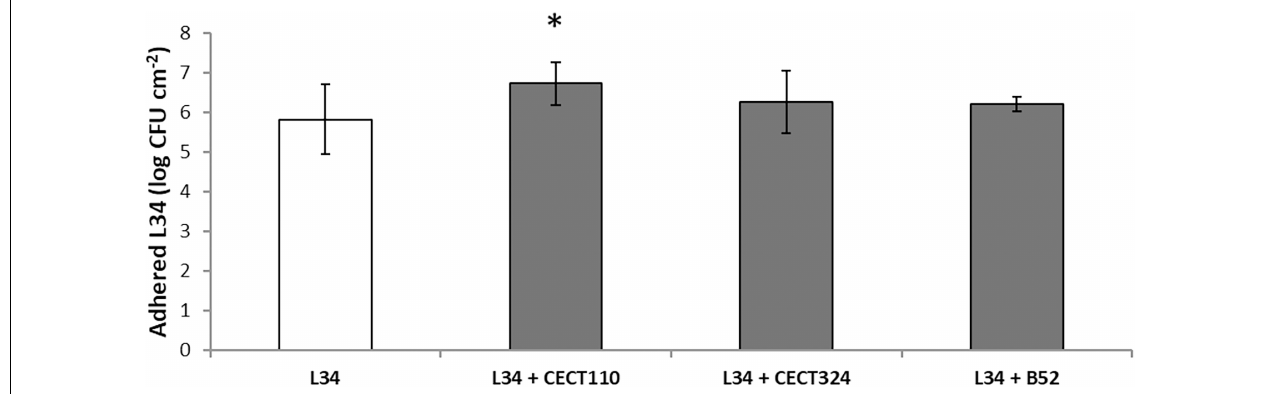
FIGURE 2 | Plate count values of adhered viable cells (AVC) corresponding to 48 h control biofilms grown on AISI 316 SS coupons. Bars represent mean values ( n = 15) expressed in CFU cm - 2 of L. monocytogenes L34 mono-species biofilms (void) and in dual-species biofilms with Pseudomonas spp. (gray). Error bars represent the samples’ standard error. Asterisk indicates statistical significance (two-tailed Student’s t -test, α = 0.05).